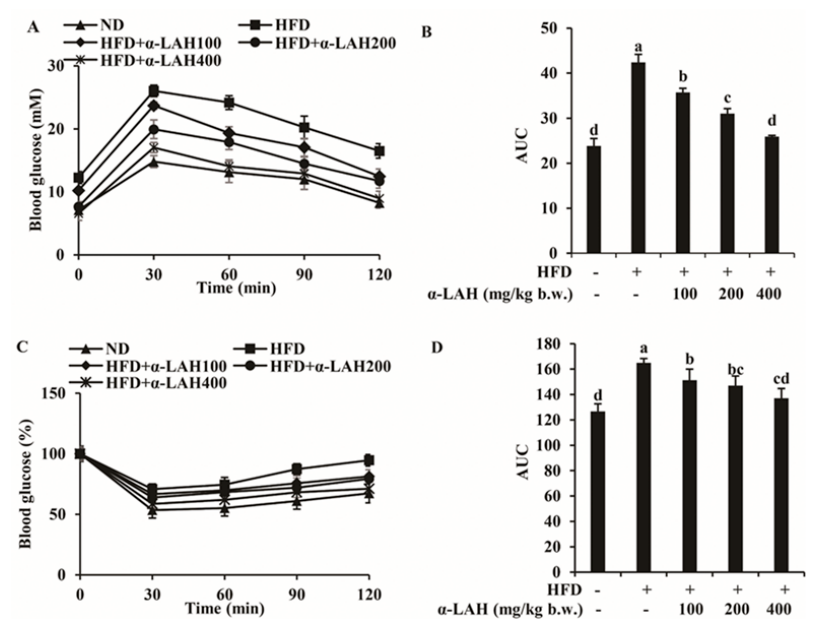
Figure 3. Effect of bovine α -lactalbumin hydrolysates ( α -LAH) supplementation on glucose tolerance and insulin tolerance in mice fed with high-fat diet. ( A ) The results of oral glucose tolerance test (OGTT). After an overnight fast, mice were administered glucose (2 g/kg b.w., oral). Blood samples were collected from the tail before (0 min) and 30, 60, 90 and 120 min after glucose administration to measure blood glucose; ( B ) area under the curve (AUC) for the blood glucose levels during oral glucose tolerance test (OGTT); ( C ) the results of intraperitoneal insulin tolerance test (ipITT). After a 6-h fast, mice were administered insulin (0.75 U/kg b.w., intraperitoneal injection). Blood samples were collected from the tail before (0 min) and 30, 60, 90 and 120 min after insulin injection to measure blood glucose; ( D ) area under the curve (AUC) for the blood glucose levels during intraperitoneal insulin tolerance test (ipITT). All data were presented as means ± standard deviations (SD) ( n = 10). Significance was determined by one-way analysis of variance (ANOVA) with the Duncan’s multiple-comparison test, and mean values without common letters indicate differences at p < 0.05.